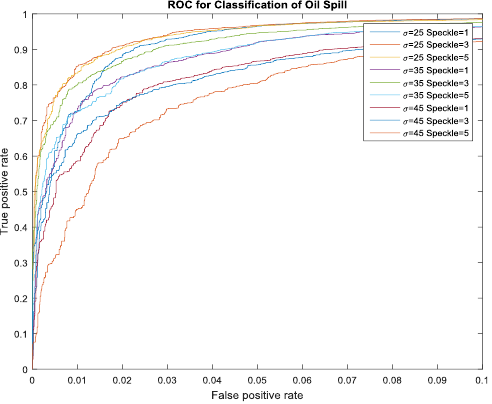
Figure 6. ROC curves for different noise levels.